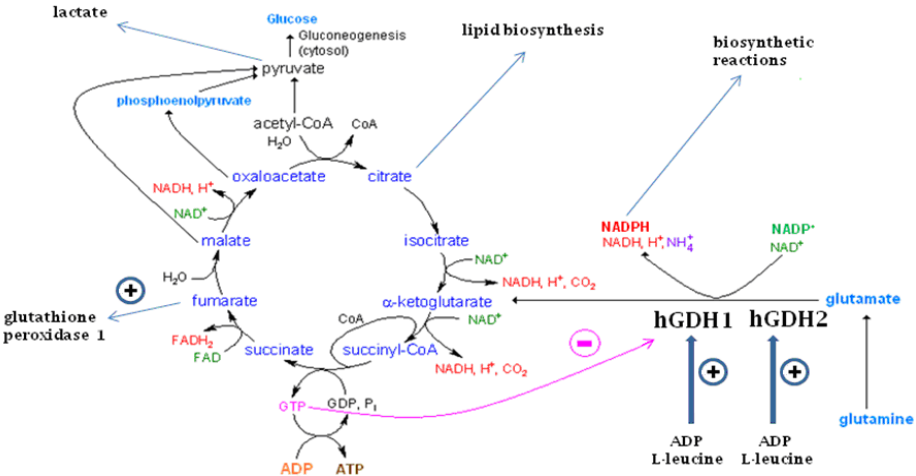
Figure 1. The glutamate dehydrogenase (GDH) pathway and the Krebs cycle function. As shown here, oxidative deamination of glutamate by hGDH1 and hGDH2 generates α-ketoglutarate, ammonia and NADH or NADPH. While α-ketoglutarate is metabolized by the Krebs cycle, NADPH can be used for biosynthetic reactions. GTP generated at the step of succinyl-CoA to succinate potently inhibits hGDH1 thus preventing glutamate from fueling this cycle under an adequate energy charge. On the other hand, hGDH2 has dissociated its function from GTP control and as such it permits glutamate flux under conditions inhibitory to hGDH1. Both enzymes are activated by ADP